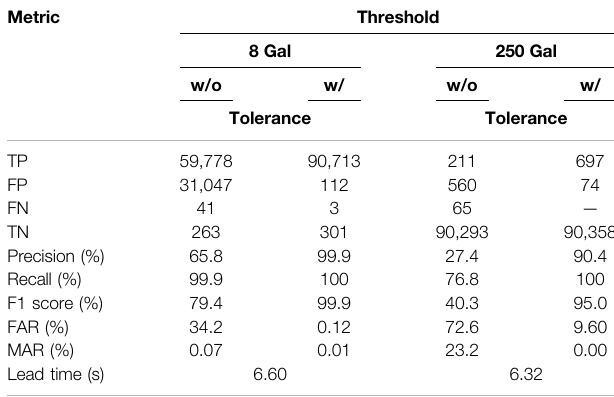
TABLE 6 | The performance metrics of the TSMIP data set using the proposed LSTM model with different PGA thresholds.